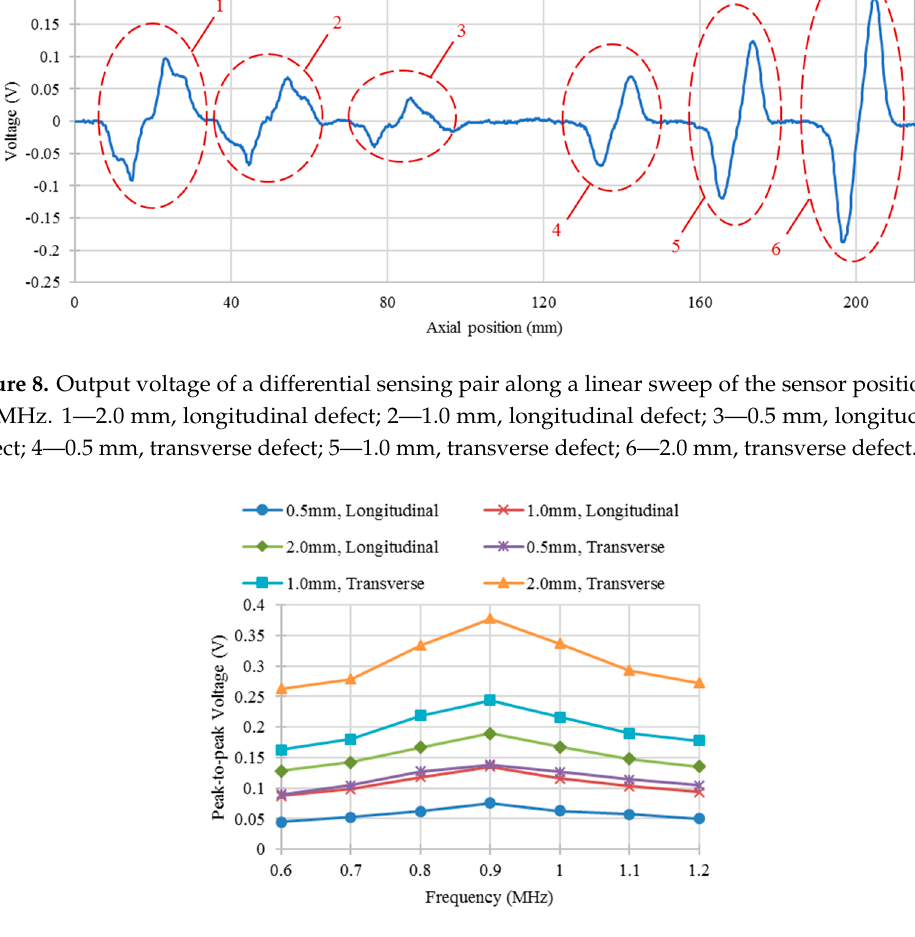
Figure 9. Peak-to-peak voltage for different kinds of defects at different frequencies from experiment. Table 1. The relative errors of results from experiment and simulation (%).